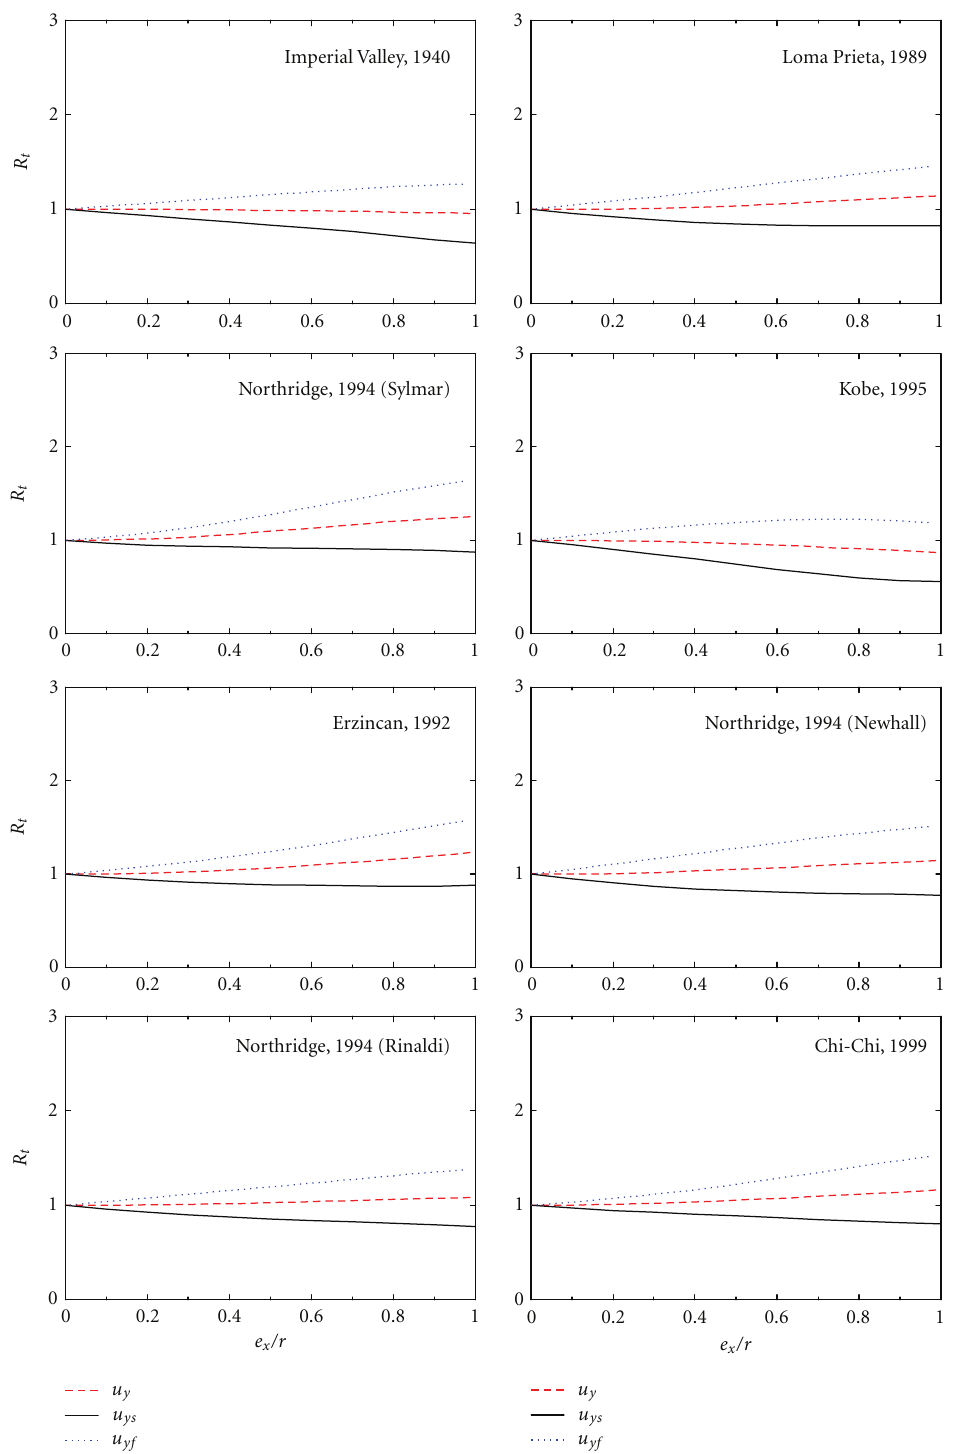
Figure 12: E ff ect of eccentricity on response ratio, R t for various peak displacements ( T y = 1 s, Ω θ = 2). Ω = 1, the control forces at sti ff edge will be overestimated θ and at flexible edge that will be underestimated.